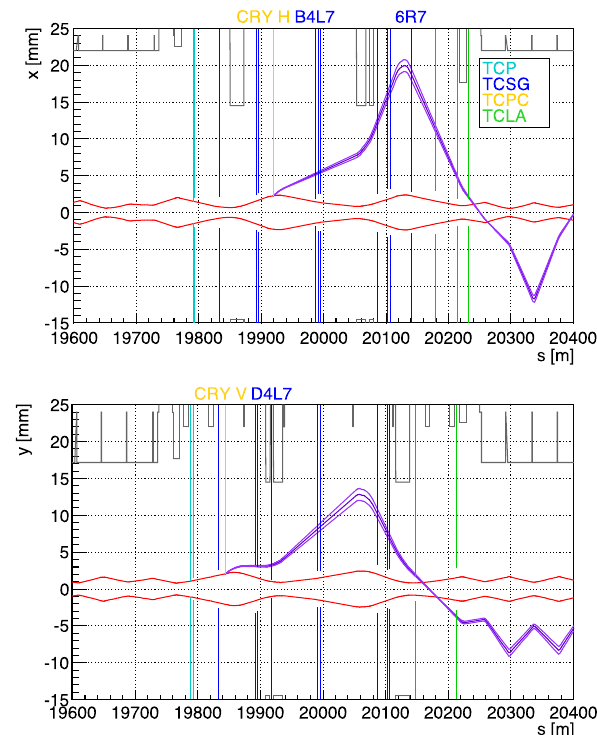
Fig. 1 Trajectory of channeled halo particles (purple lines) for the hor- izontal (top graph) and vertical (bottom) crystals for the beam tests con- figurations at 6.5Z TeV. The envelope of the circulating beam at the amplitude of the crystal settings (5.5 σ in this case) is also given (red lines). Vertical lines indicate the aperture of the IR7 collimators in the plane of interest and black lines show the (fixed) aperture other machine